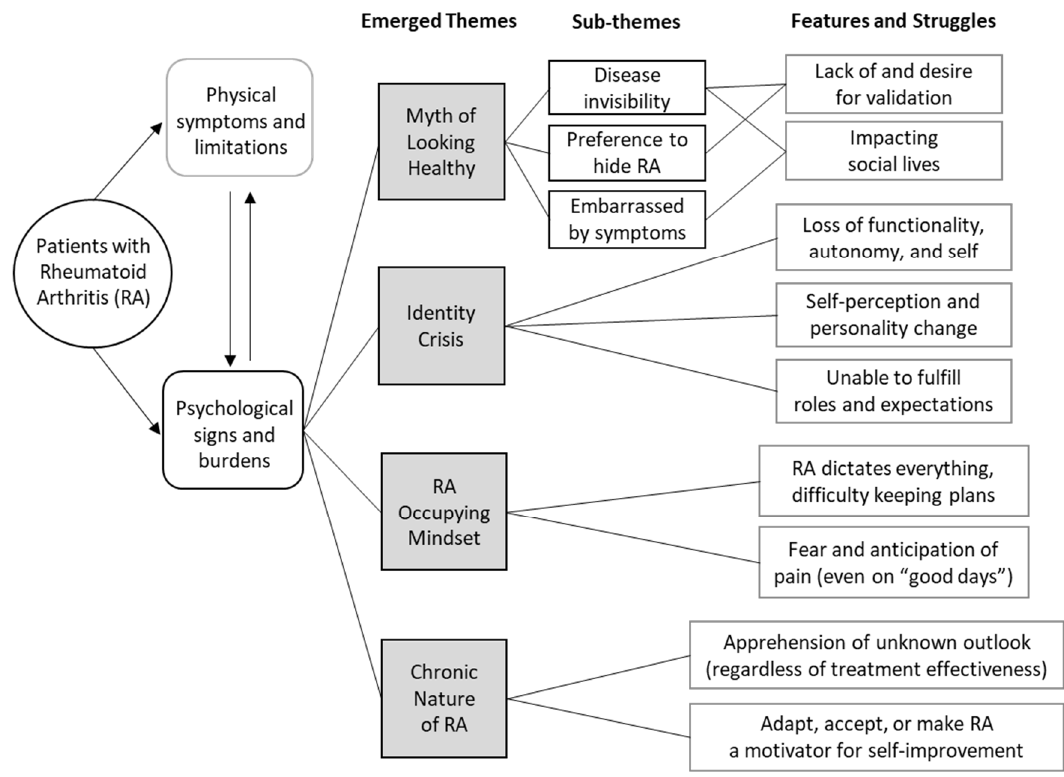
Figure 1. Identified themes and struggles from RA patient interviews.